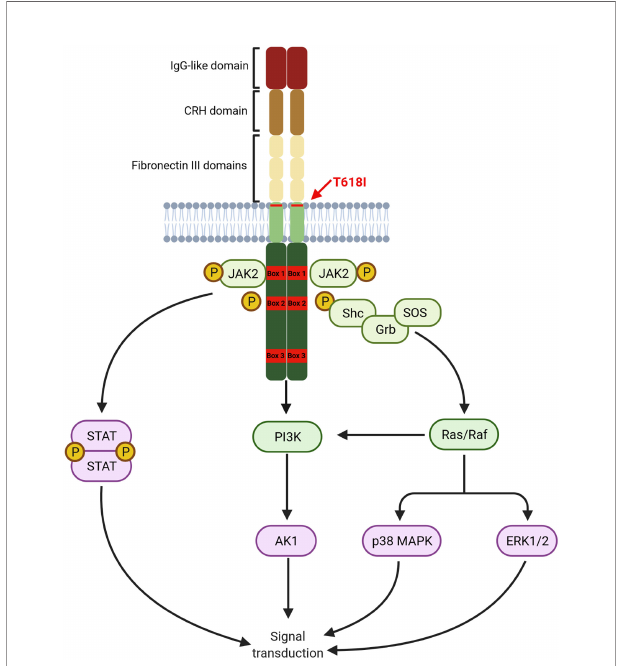
FIGURE 1 | Structure of CSF3R. Proximal transmembrane T618I mutation induced a G-CSF independent activation of receptor homodimers leading to constant signal transduction primarily through the JAK/STAT pathway. Other pathways, namely PI3K/AKT and ERK1/2 are also constantly activated ( Created with BioRender.com